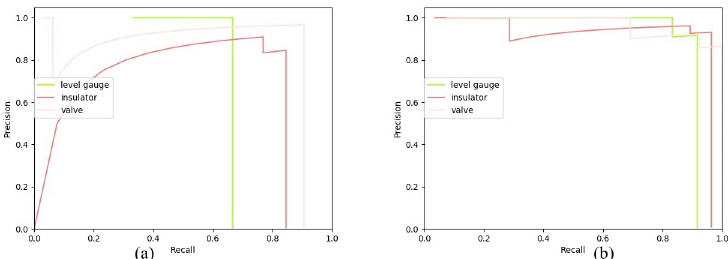
Fig 9. P-R curve contrast. (a) P-R curve of Faster R-CNN (b) P-R curve of ROMS R-CNN. It represents the AP comparison curve using two algorithms Faster R-CNN and ROMS R-CNN to detect the three categories of liquid level gauge, valve and insulator.